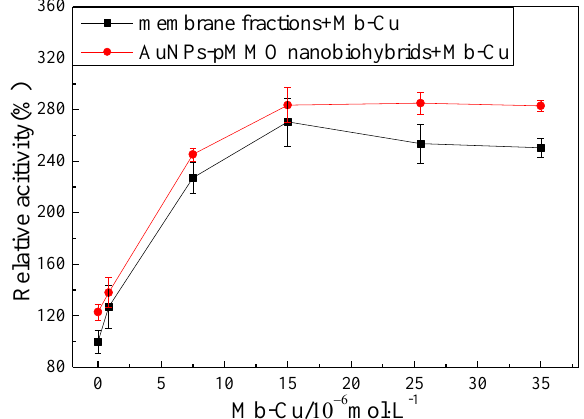
Figure 8. E ff ect of Mb–Cu concentration on the activity of membrane fractions and AuNP–pMMO Figure 8. Effect of Mb–Cu concentration on the activity of membrane fractions and AuNP–pMMO nanobiohybrids (5 × 10 − 3 mol / L dimethyl hydroquinone was added to the reaction; 100% epoxidation nanobiohybrids (5 × 10 −3 mol/L dimethyl hydroquinone was added to the reaction; 100% epoxidation activity = 3.24 nmol · min − 1 · mg − 1 activity = 3.24 nmol∙min −1 ∙mg −1 ).